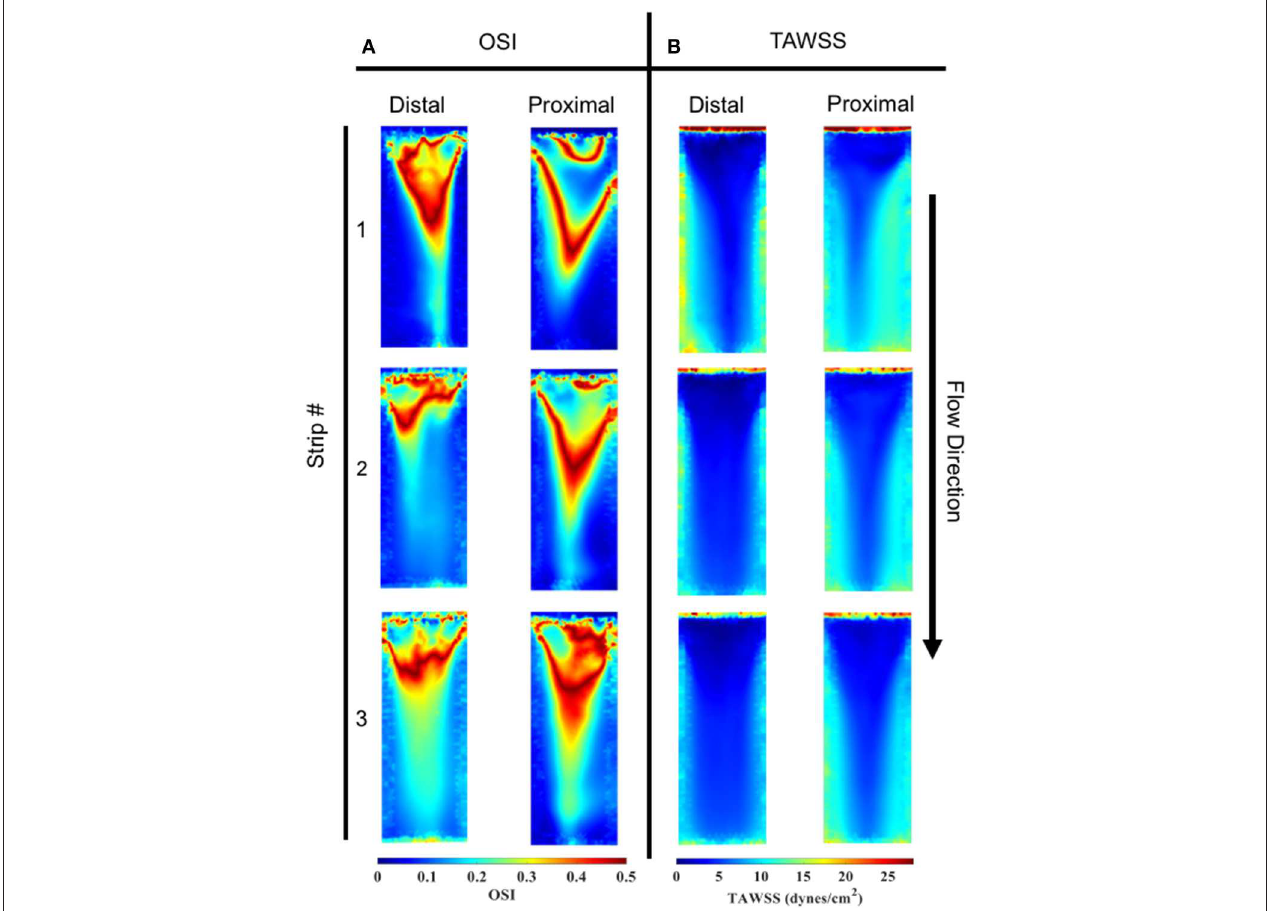
FIGURE 9 | OSI and TAWSS contours across all three specimens for both the distal and proximal sides. (A) In order of specimen number OSI averages were; Distal: 0.145, 0.170, and 0.211, Proximal: 0.148, 0.163, and 0.189. (B) In order of specimen number TAWSS (dynes/cm 2 ) averages were: Distal: 8.985, 7.703, and 6.122, Proximal: 9.057, 7.944, and